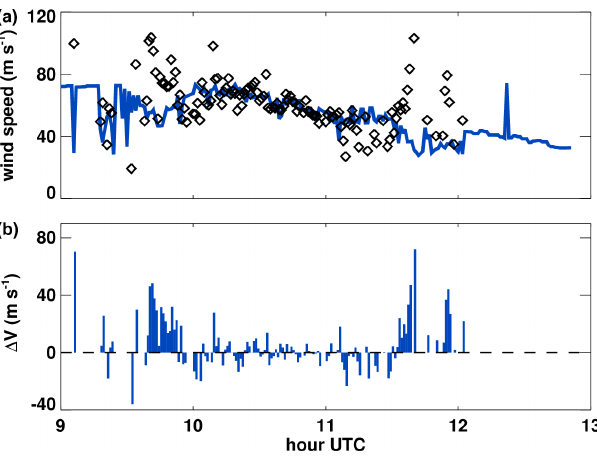
Figure 6. 30min averages of meridional (a) and zonal (b) com- ponents of wind and vertical wind shear magnitude (c) calculated from NSMR meteor detection radial velocities in 2km height bins. The dashed line shows the approximate height (range bin of max- imum intensity) of PMSE detection by NSMR. Dotted boxes indi- cate PMSE detection periods. Gray squares denote insufficient data.